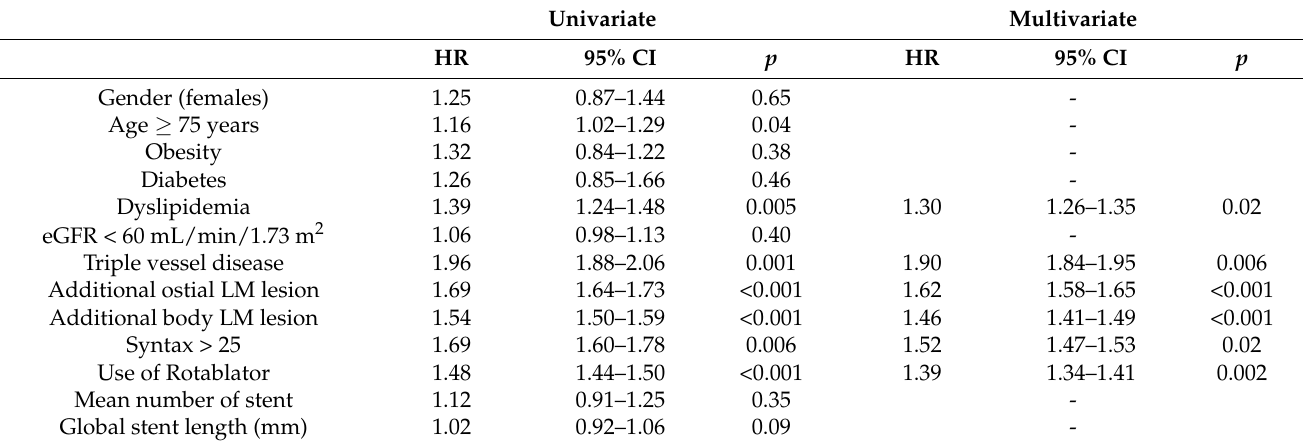
Table 6. Univariate and Multivariate Cox Regression analysis for TLF at three years of follow-up. Univariate Multivariate HR 95% CI p HR 95%